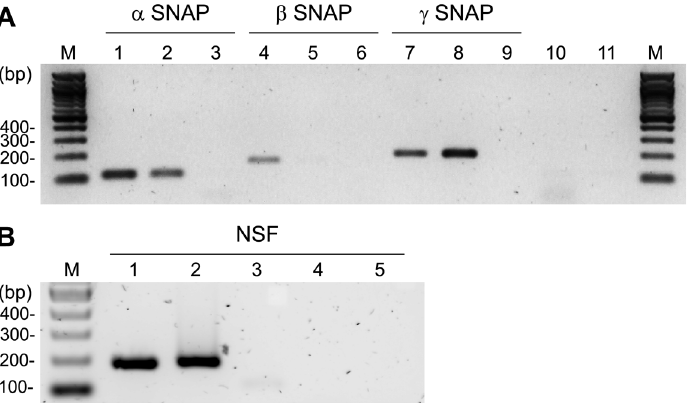
Fig 1. Gene Expression of SNAP isoforms and NSF in mouse oocytes. A . Detection of SNAPs mRNA. Lanes 1 – 3 and 10 – 11 were amplified using α -SNAP primers, lanes 4 – 6 using β -SNAP primers, and lanes 7 – 9 using γ -SNAP primers under the same experimental procedure. Agarose gel was stained with ethidium bromide. Lanes: M, molecular weight marker; 1,4, and 7,mouse brain; 2, 5, and 8, GV oocytes; 3, 6, and 9, PCR negative controls without cDNA; 10 and 11, RT-PCR negative controls without reverse transcriptase (RT) for brain and oocytes samples, respectively. B . Detection of NSF mRNA. All lanes were amplified using NSF primers and agarose gel was stained with SYBR safe. Lanes: M, molecular weight marker; 1,mouse brain; 2, mouse oocytes; 3, PCR negative control without cDNA; 4 and 5, RT-PCR negative control without RT for brain and oocytes samples, respectively. Shown are images representative of 3 independent